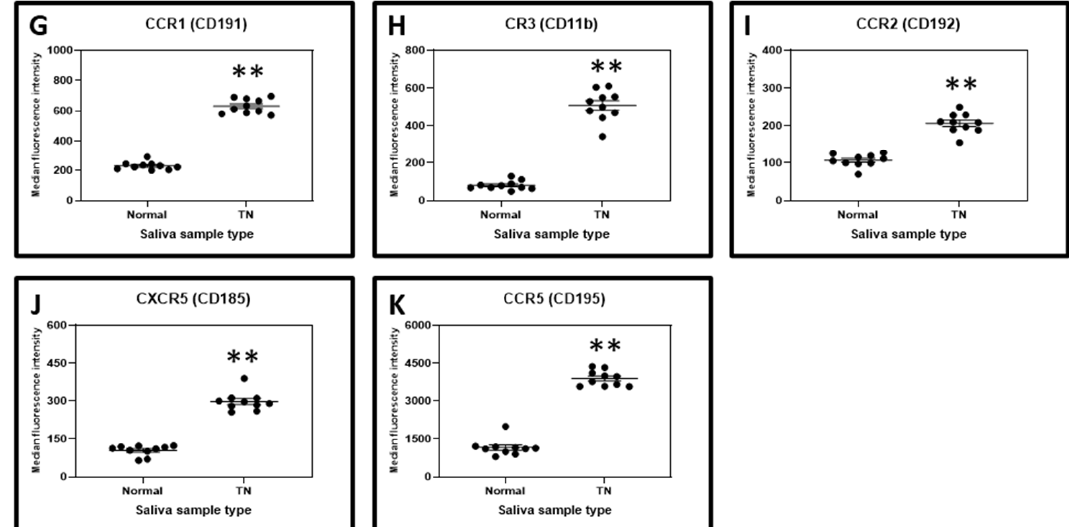
Figure 4. Chemokine receptor analysis by flow cytometry. ( A ) Cells isolated from saliva. Scale bar = 40 µ m. ( B ) Median fluorescence intensity (MFI) of CD191 in the salivary cells from normal and TN subjects. ( C ) MFI of CD11b in the salivary cells from normal and TN subjects. ( D ) MFI of CD192 in the salivary cells from normal and TN subjects. ( E ) MFI of CD185 in the salivary cells from normal and TN subjects. ( F ) MFI of CD195 in the salivary cells from normal and TN subjects. ( G – K ) Comparative markers analysis of salivary cells from normal and TN subjects of chemokine receptors CD191, CD11b, CD192, CD185, and CD195. ** p < 0.01. CCR1 (CD191): C-C chemokine receptor type 1, CR3 (CD11b): Complement receptor 3, CCR2 (CD192): C-C chemokine receptor type 2, CXCR5 (CD185): C-X-C chemokine receptor type 5, CCR5 (CD196): C-C chemokine recep- tor type 5.